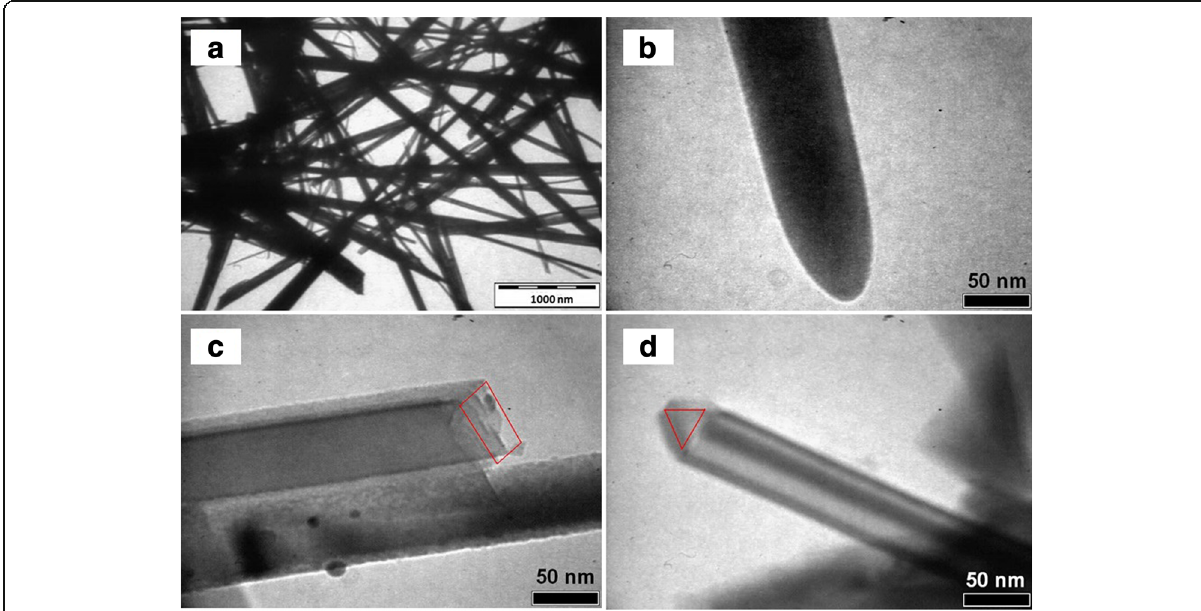
Fig. 5 TEM images of loose SiNWs: a bundle of SiNWs with various sizes and shapes, b round-shaped SiNW, c rectangular-shaped SiNW, and d triangular-shaped SiNW